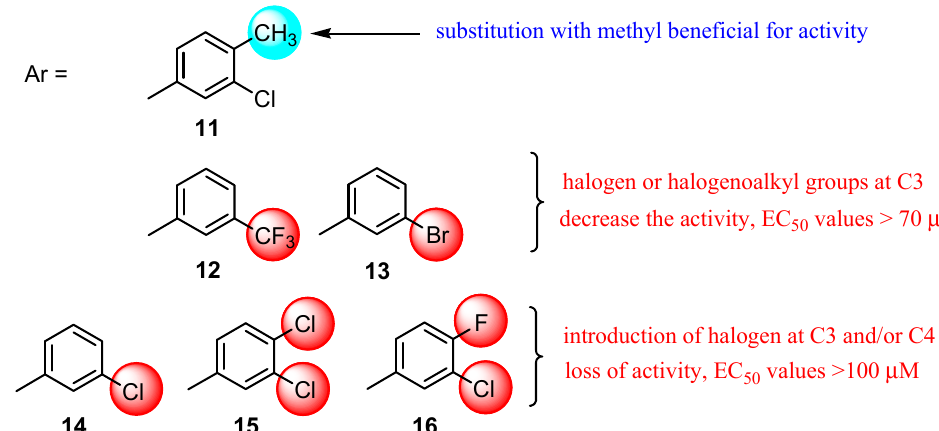
Figure 3. The influence of substituents of 1,3,4-thiadiazole derivatives 11 – 16 on anti-HIV activity.